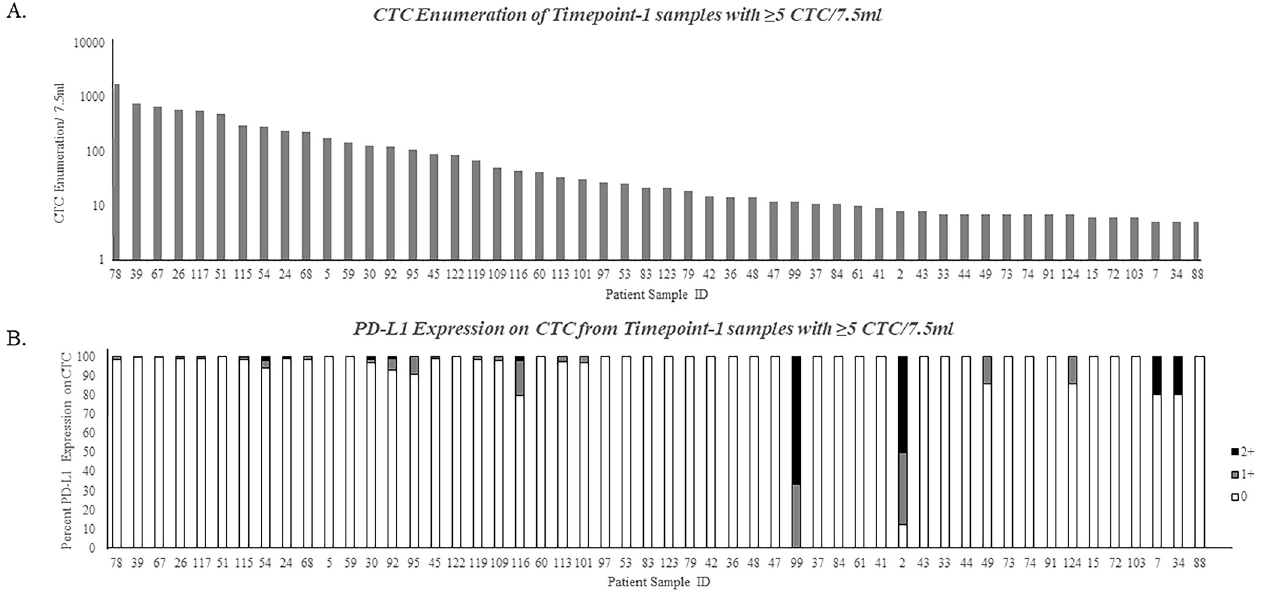
Fig 1. CTC Enumeration and CTC PD-L1 Expression at timepoint-1. Whole blood (WB) specimens from 124 patients with metastatic breast cancer were processed using the CellSearch 1 system. Circulating tumor cell (CTC) enumeration and PD-L1 expression are displayed for the 52 (42%) subjects who had elevated CTC ( � 5 CTC/7.5ml WB) at timepoint-1. Numbers under each bar represent subject study designations. A. Distribution of CTC enumeration. Each bar represents the number of CTC in an individual patient sample. B. Distribution of CTC PD-L1 staining. Colors represent the percent of CTC that expressed PD-L1, on a scale of 0-3+ (see Methods for details). 0 ( ■ white), 1+ ( ■ gray), and 2+ ( ■ black). No patients had 3+ staining for CTC PD-L1.